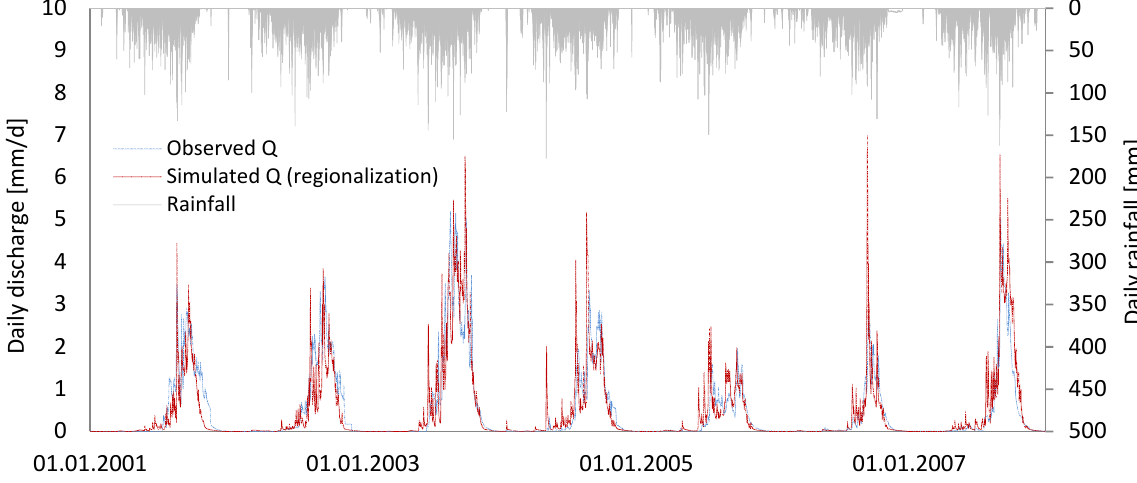
Figure 7. Observed vs. simulated total discharge (validation) using the regression-based parameters for the Savè catchment (23,488 km 2 ), with 0.71 for R 2 and 0.67 for model efficiency (ME). Savè was chosen for the validation because measurements at Ouémé-Bonou are not